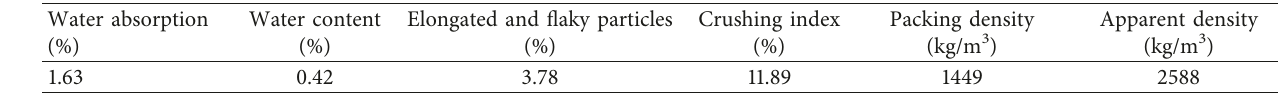
Table 2: Technical index of coarse aggregate.